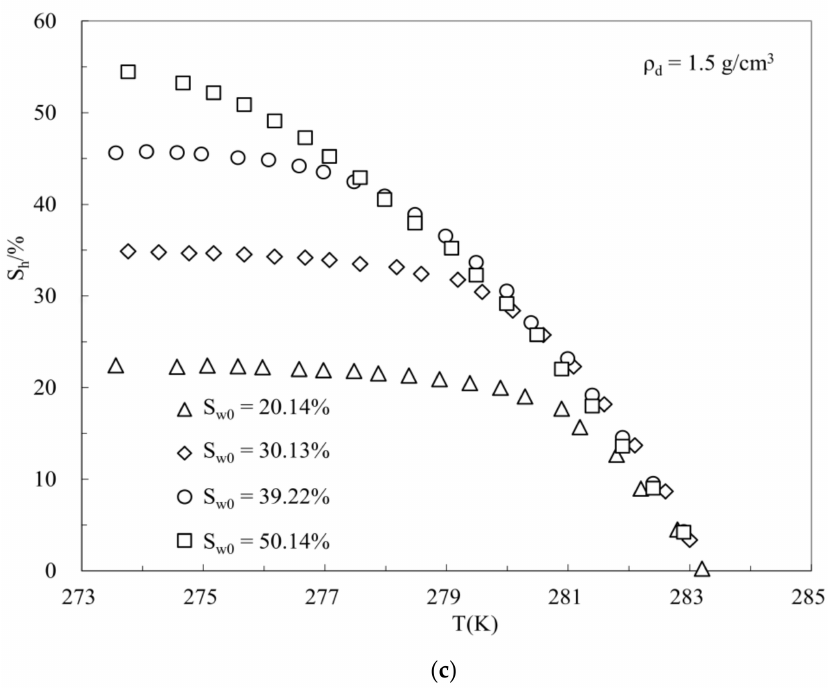
Figure 8. Temperature dissociation curve of methane hydrate in fine-grained sediment. ( a ) Low initial water saturation; ( b ) high initial water saturation; ( c ) different saturation at the same dry density.